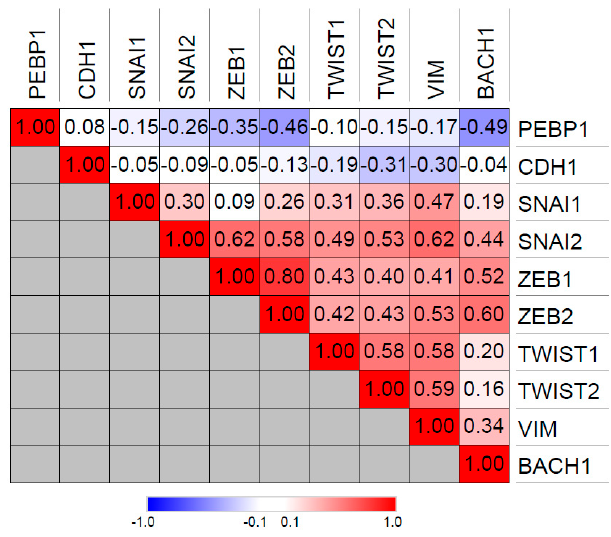
Figure 2. Spearman correlations between PEBP1 (RKIP), BACH1 (BTB domain and CNC homolog 1) and the EMT genes CDH1 (E-cadherin), SNAI1 (Snail) , SNAI2 (Slug), ZEB1 (Zinc Finger E-Box Binding Homeobox 1), ZEB2 (Zinc Finger E-Box Binding Homeobox 2)